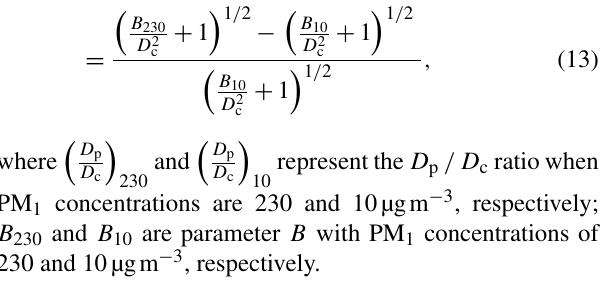
Figure 4. (a) Correlation between the changing rate of calculated E ab ( k E campaign period. (b) Frequency distribution of k E calculated E ab and PM 1 concentration, respectively, and are from point-by-point differences of hourly E ab and PM 1 concentration, namely = ( E k E ab ,t 2 - E ab ,t 1 )/ ( E ab , t1 *( t 2 - t 1 ) ) and k PM 1 ab